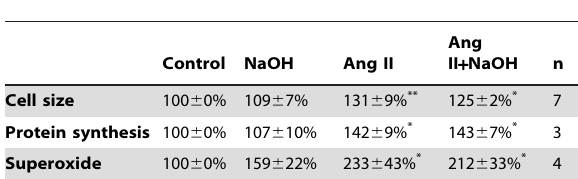
Table 1. NaOH (0.01 mol/L), the vehicle used for Angeli’s salt, does not affect neonatal rat cardiomyocyte responses, alone or in the presence of Ang II (1 m mol/L).